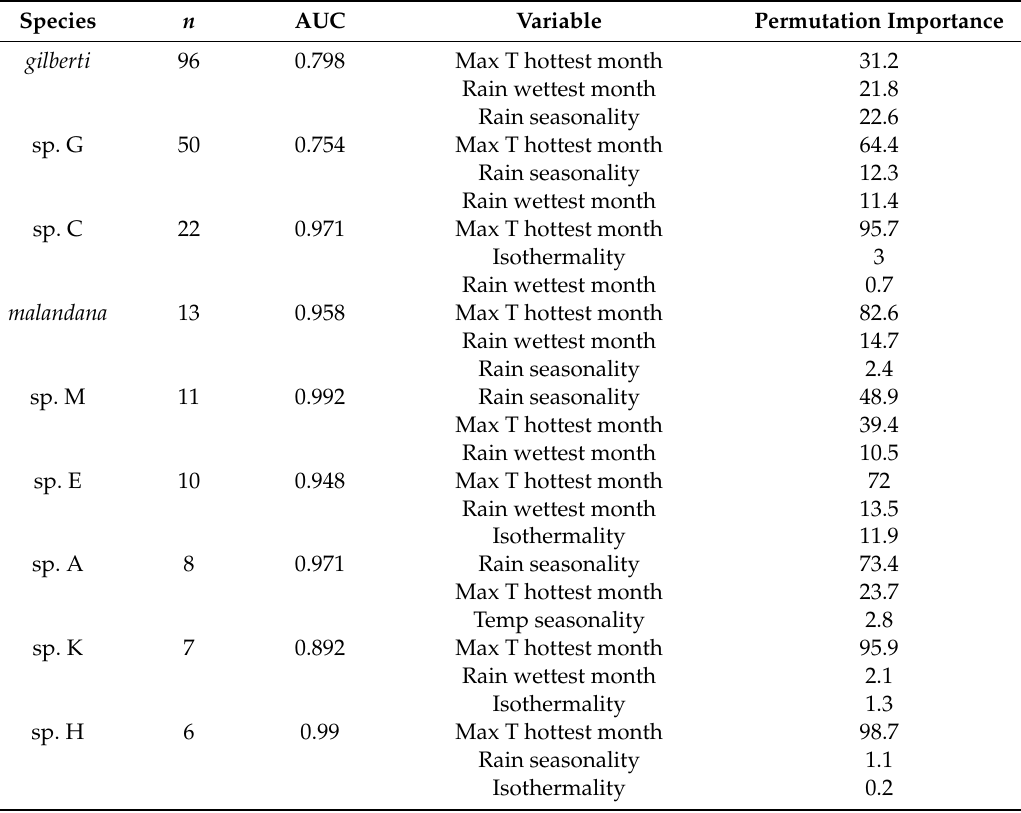
Table 2. Species distribution model outputs for nine species showing the three highest ranking environmental variables and their permutation importance in the model. AUC = area under the curve, a value between 0 and 1 indicates model performance, and higher AUC scores indicate better model fit. n = number of unique survey location points for each species. Max T hottest month = Maximum temperature of the hottest month, Rain seasonality = Rainfall seasonality, Rain wettest month = Rainfall of the wettest month, Temp seasonality = Temperature seasonality. AUC Variable Permutation